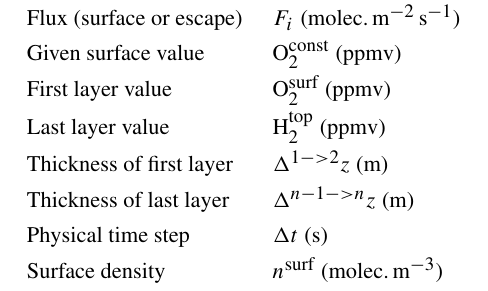
Figure 2. Oxygen atmospheric loss ( F O O 2 for a surface CH 4 from 10 − 6 to 10 − 3